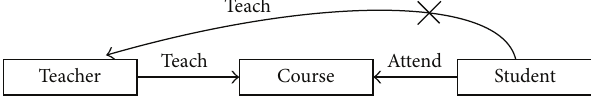
Figure 4: A relationship